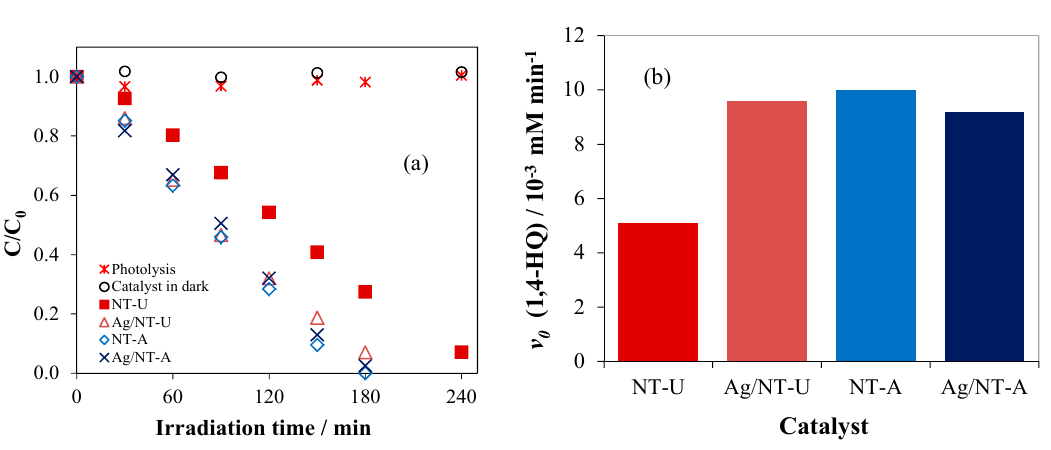
Figure 11. ( a ) C / C 0 and ( b ) degradation rate of 1,4-HQ over various catalysts. Figure 11. ( a ) C/C 0 and ( b ) degradation rate of 1,4-HQ over various catalysts.